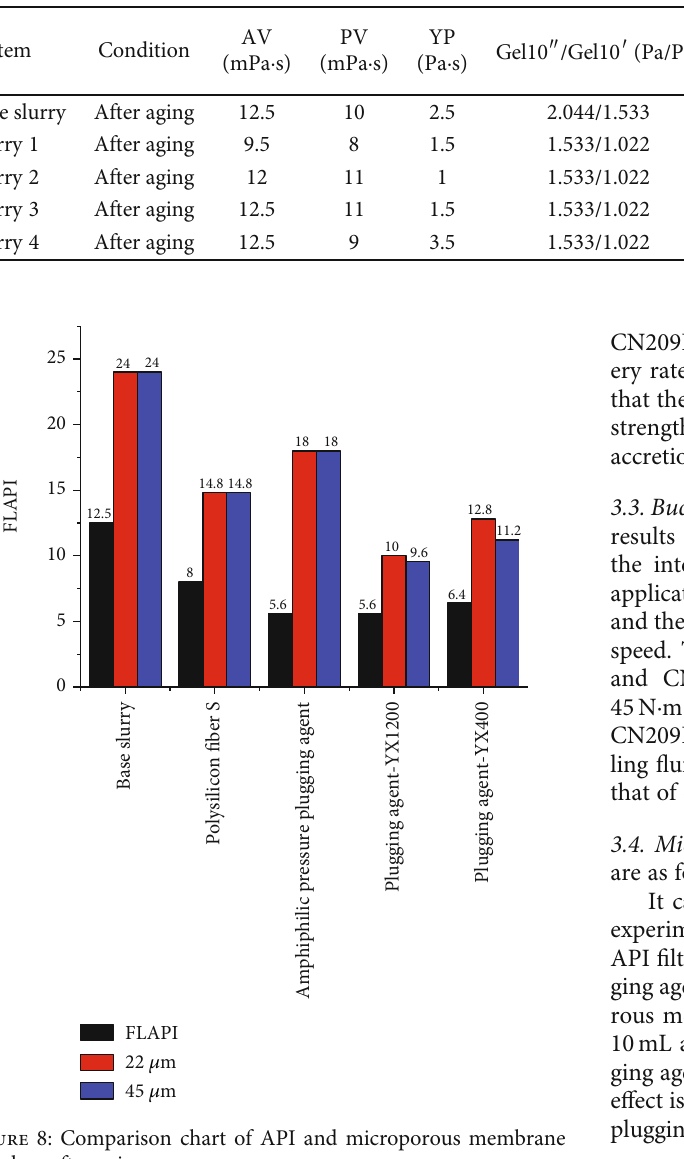
Table 3: Optimal experimental results of plugging agents.